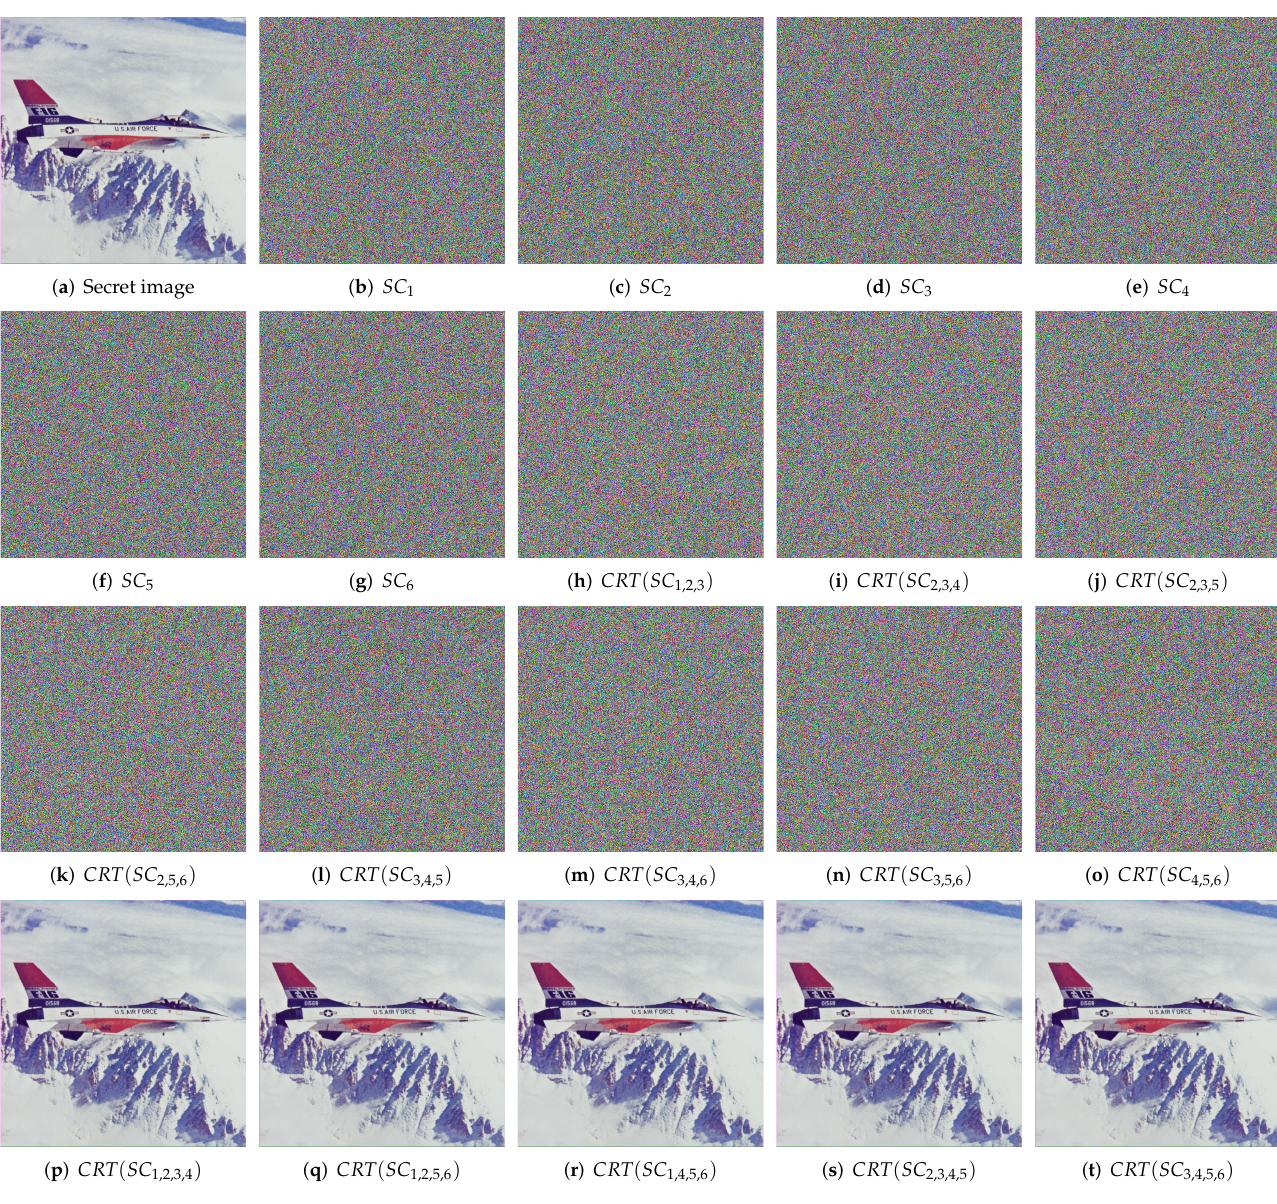
Figure 8. Experimental results of the introduced scheme for the ( 4,6 ) threshold. ( a ) Secret image; ( b – g ) six generated shares SC 1 , SC 2 , SC 3 , SC 4 , SC 5 and SC 6 ; ( h – o ) eight recovered images with three shares; ( p – t ) five recovered images with four